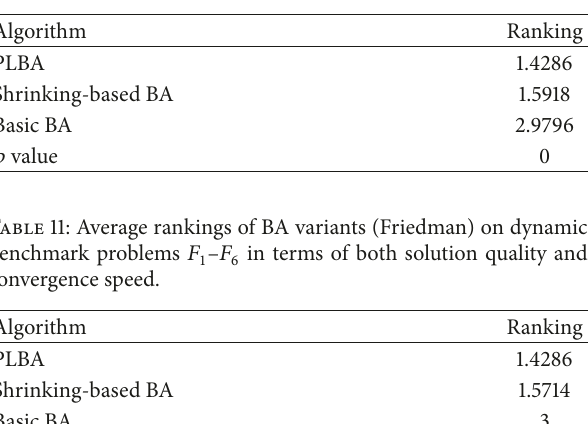
Table 10: Average rankings of BA variants (Friedman) on dynamic benchmark problems 𝐹 1 – 𝐹 6 in terms of the solution quality.